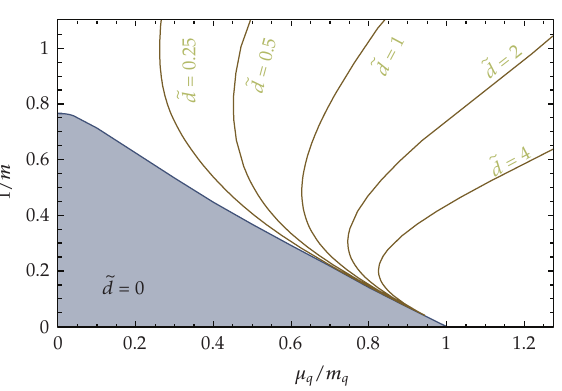
Figure 5: The phase diagram of fundamental matter in the D3/D7 setup. Horizontal axis: Chemical potential normalized to the quark mass. Vertical axis m − 1 ∝ T/m q . In this work we analyze the white (cid:11) region of finite particle density d , for which we show some lines of constant values for (cid:11) between d and n B is given by (cid:2) 3.41 (cid:3)